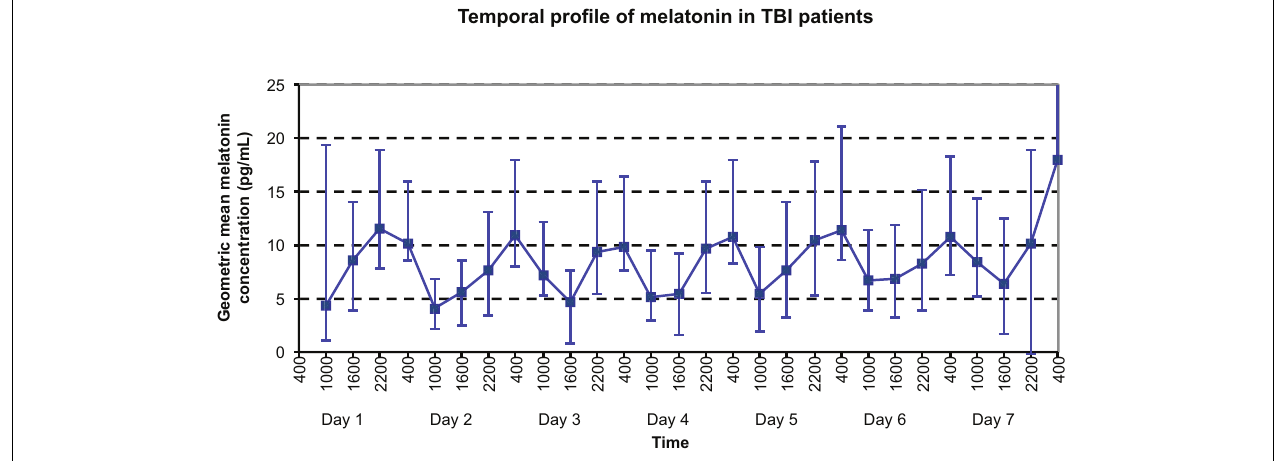
FIGURE 1 |Temporal profile of geometric mean serum melatonin concentrations inTBI patients, with peaks at 2200h on Day 1 and 0400h on Day 8, and nadir at 1000h on Day 4 .